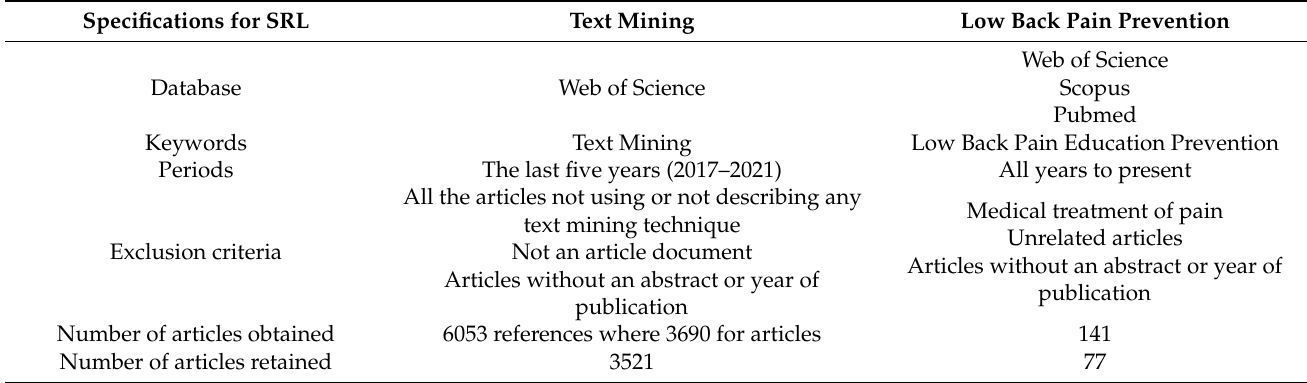
Table 3. Systematic literature review design